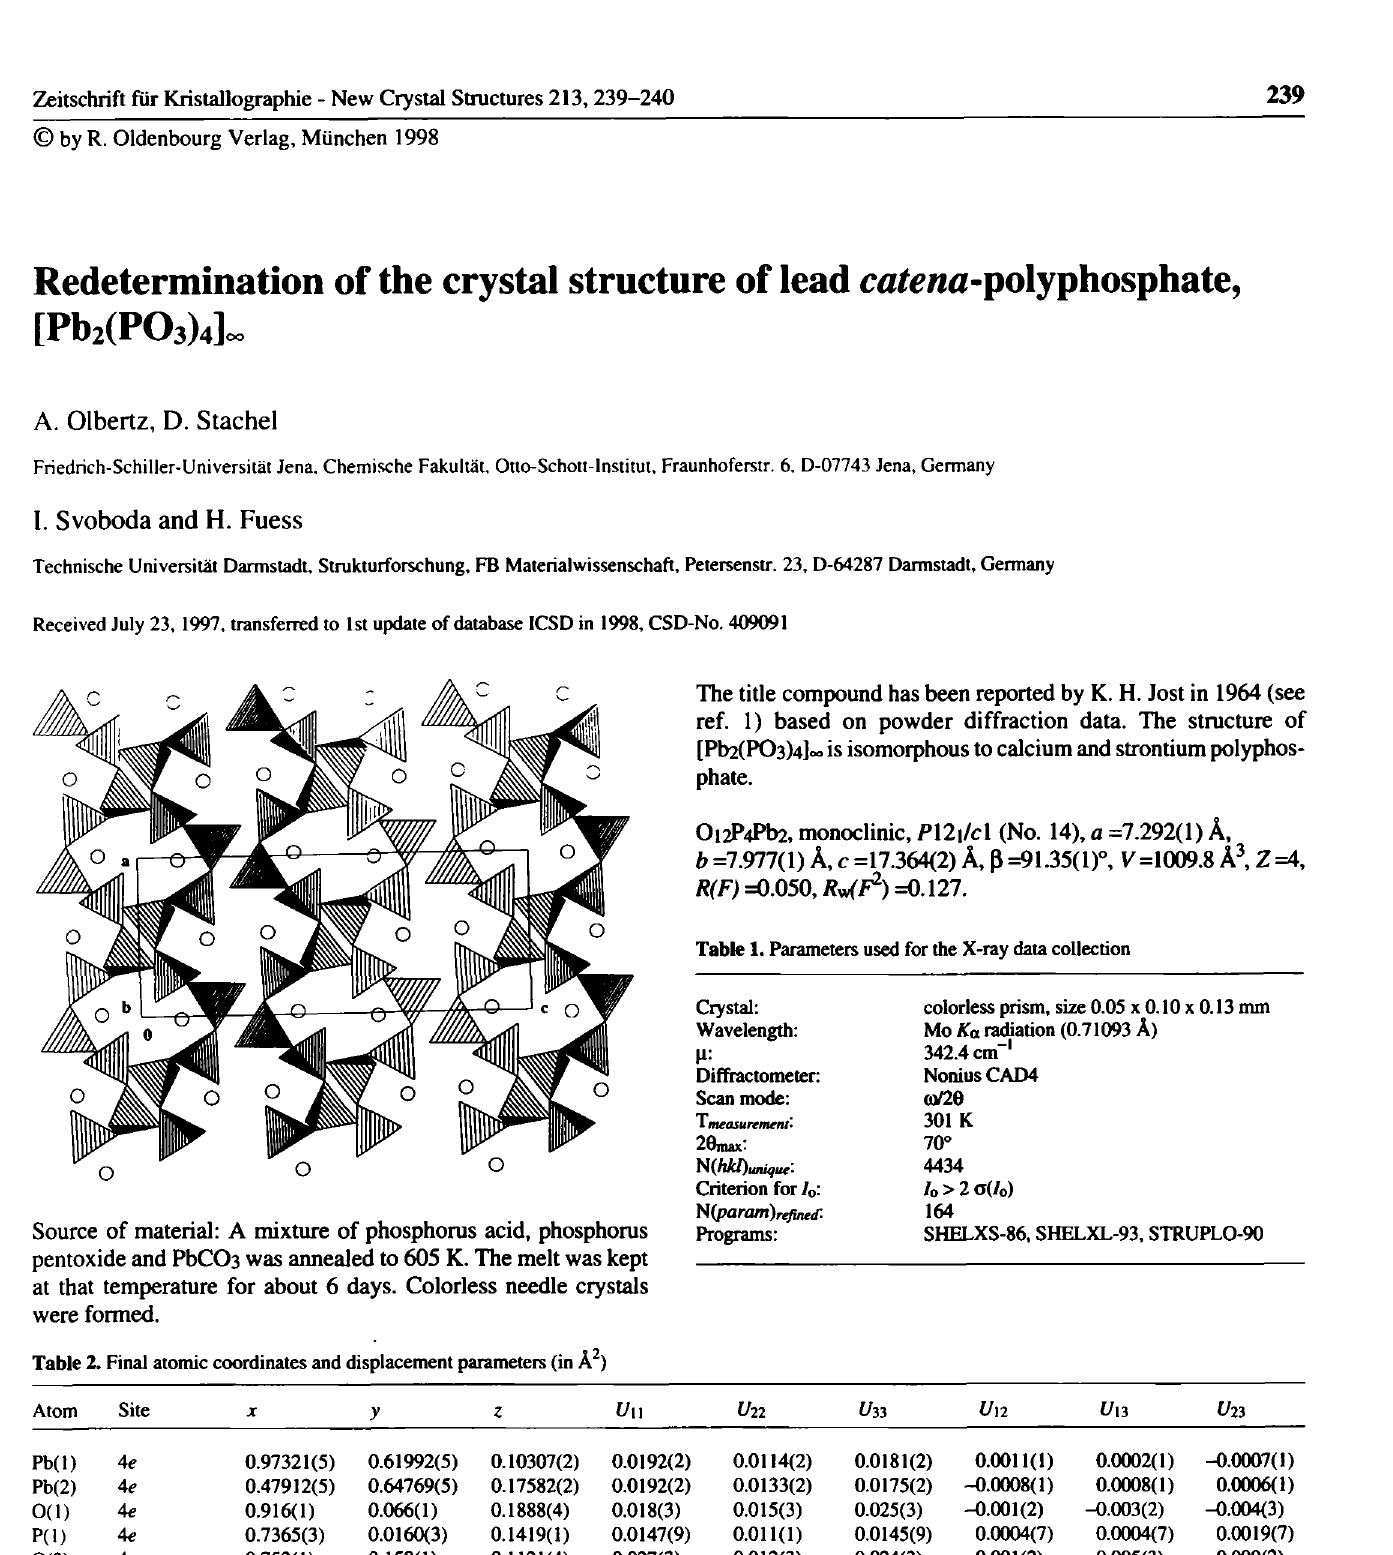
Source of material: A mixture of phosphorus acid, phosphorus pentoxide and РЬСОз was annealed to 605 K. The melt was kept at that temperature for about 6 days. Colorless needle crystals were formed. Table 2. Final atomic coordinates and displacement parameters (in Л^)